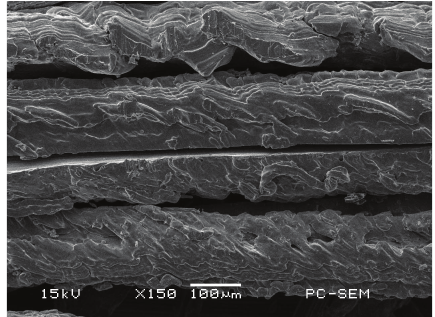
Figure 3: SEM image of the OLPM.